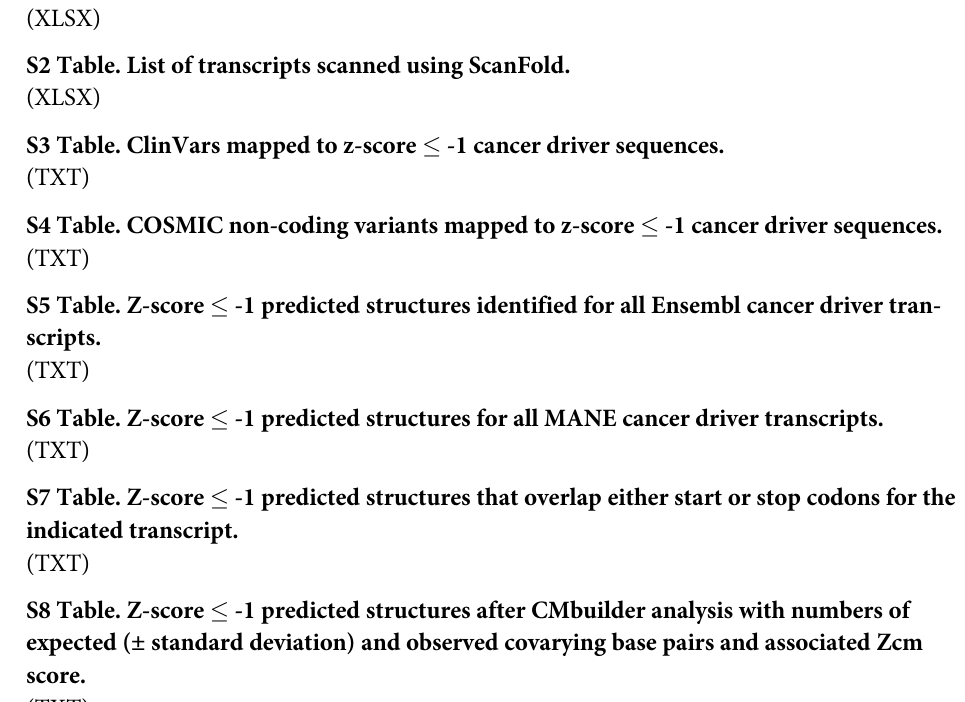
S1 Fig. ScanFold extracted structures mapped back to the genome prior to mapping vari- ants from the COSMIC non-coding database and ClinVar. (A) 25 most frequently repre- sented mutated genes (by number of structures per gene) from each of COSMIC and ClinVar are shown. (B) RNA2Dmut outputs for MSH6_10 (Musashi homolog 6 structure 10), repre- sented because it contains the lowest Zcm of the most represented structures that have at least one covarying base pair (green boxes; Rscape). Nucleotides circled in orange have reported synonymous mutations. Bases are colored according to the change in ensemble diversity (ED). The Min (blue scale) represents a reduction in ED or potentially stabilizing effect on the struc- ture. The Max (red scale represents an increase in ED or potentially destabilizing effect on the structure. Values of the structure z-score and the Zcm are given under the structure name,